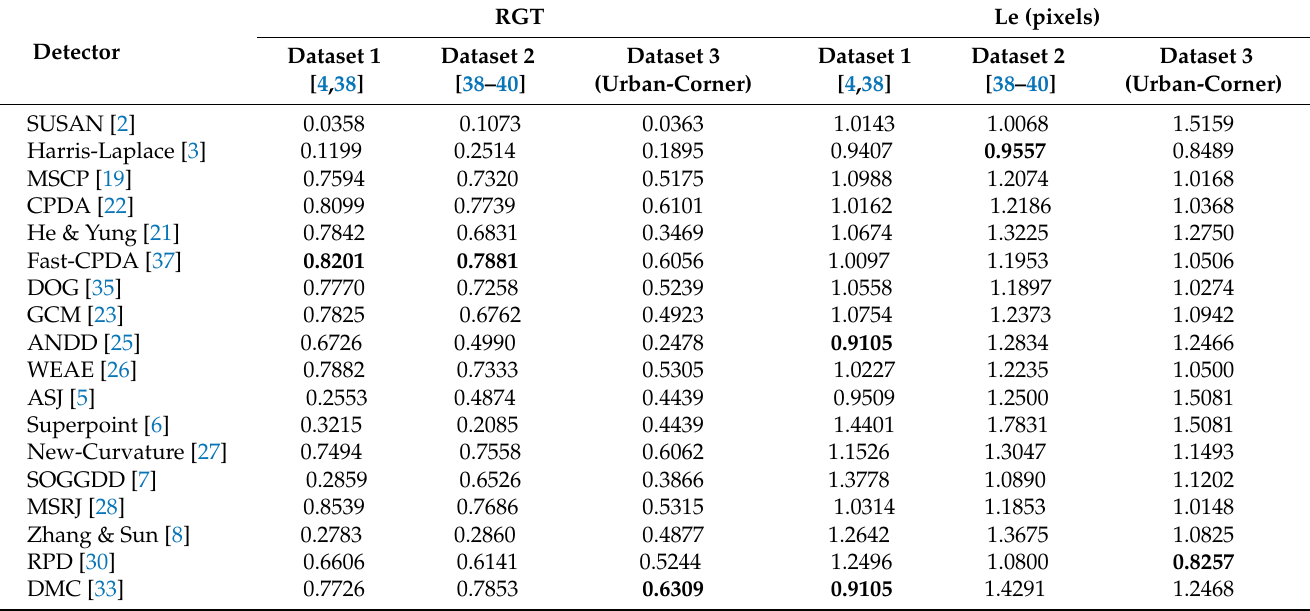
Table 3. Performance comparison of different corner detectors on three benchmark